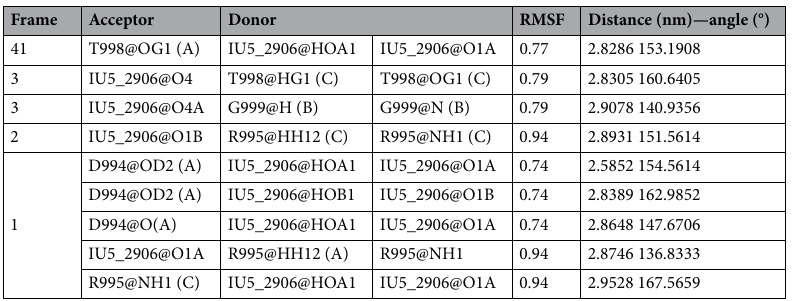
Table 2. Interactions between UDCA and T998 of central helices of S2 of Spike protein of SARS-CoV-2. These distances and angles correspond to H bonds formed during the trajectory of molecular dynamics. As observed in Fig. 2B, once these atoms are at a close distance, they remain together along the trajectory. In molecular dynamics, most of the H-bonds are at the beginning of the trajectory. H-bonds are formed between UDCA (denoted as IU5_2906 according to AMBER files) and T998, R995, D994 and G999 from three monomers (H-bonds obtained with